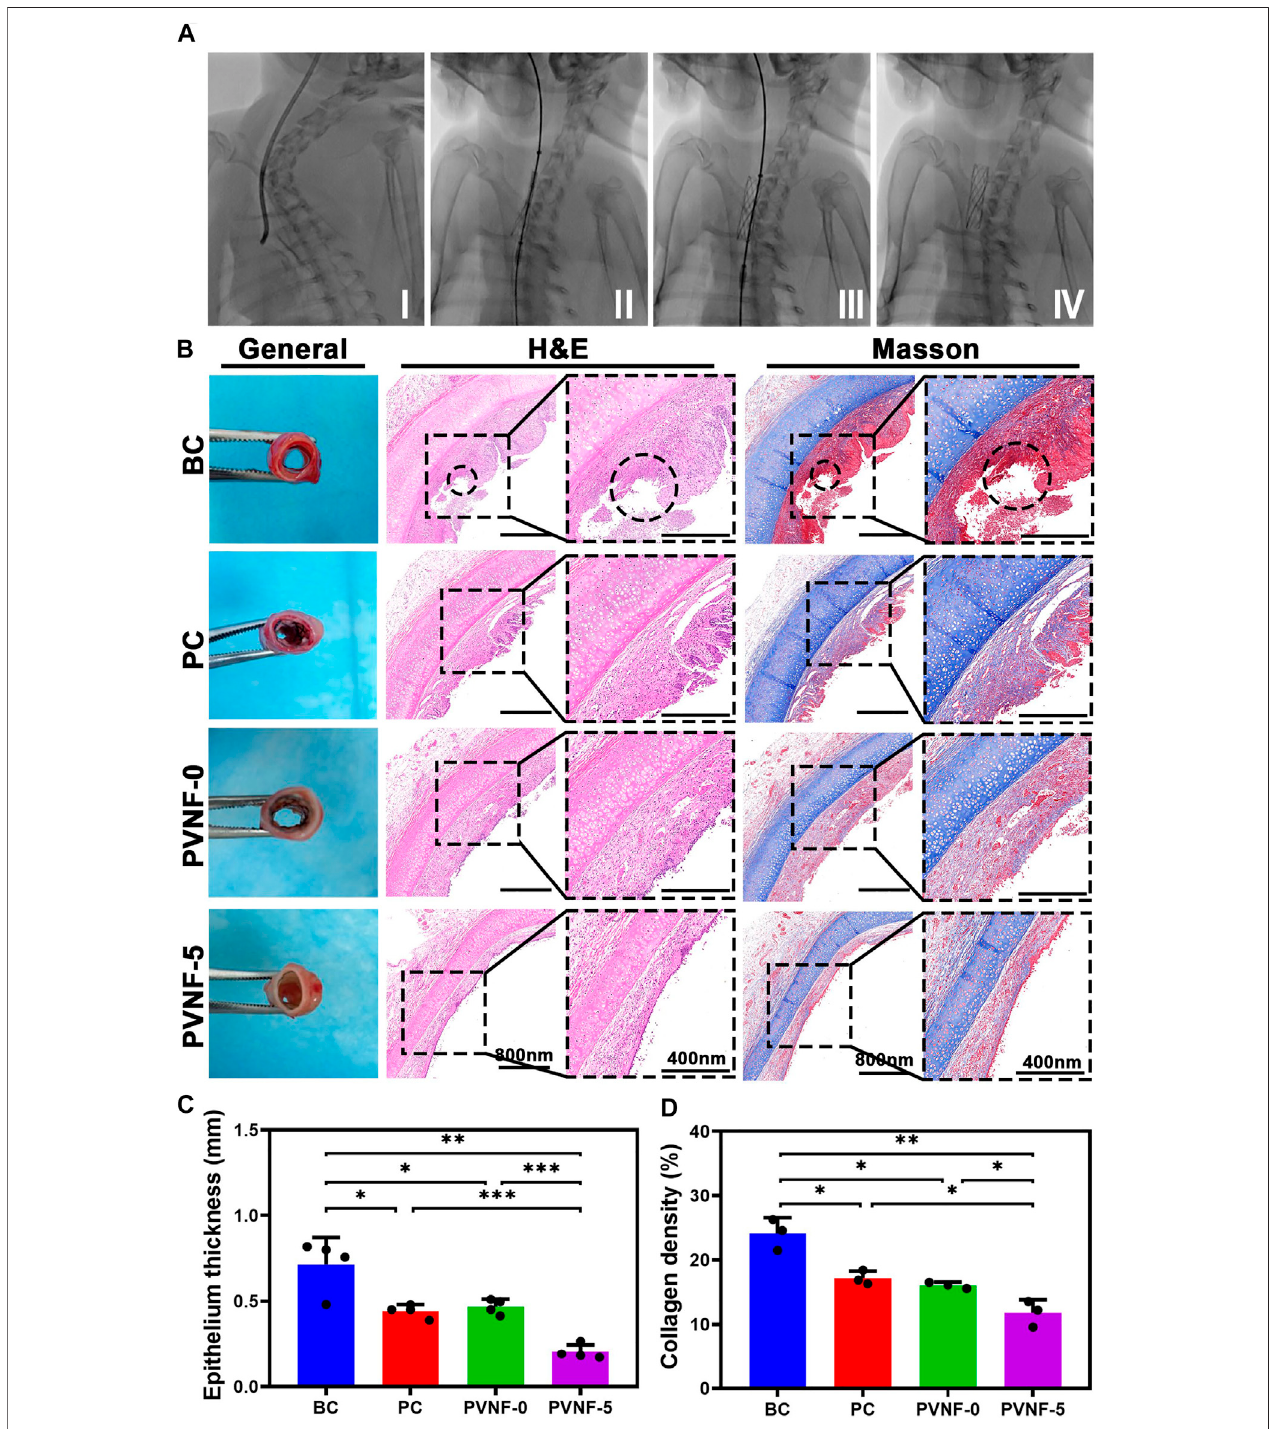
FIGURE 6 | (A) Surgical view of stent implantation. (B) General observation, HE staining and Masson ’ s staining in the bare metallic stent (blank control, BC), commercial pellosil matrix – covered stent (PC), PVNF-0 – covered metallic stent, and PVNF-5 – covered metallic stent. Circles represent the formation of ulcers. (C, D) Quantitative results of granulation tissue thickness ( N (cid:1) 4) and collagen density ( N (cid:1) 3). Scale bar: 400 μ m * p < 0.05, ** p < 0.01, and *** p < 0.001.